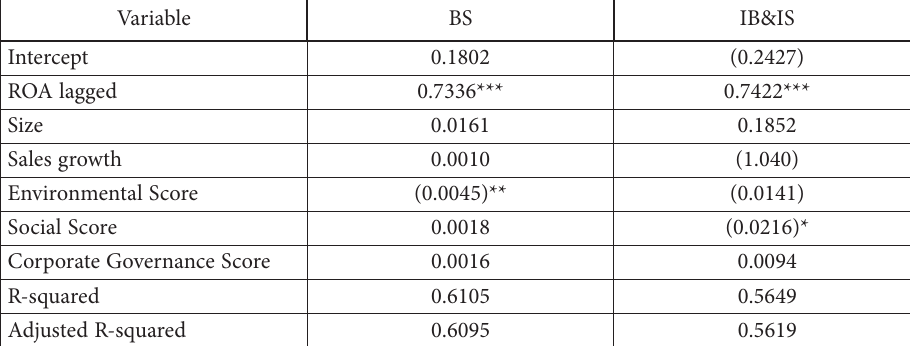
Table 3. Regression results for Tobin’s q – Banking Services (BS) and Investment Banking & Investment Services (IB&IS)